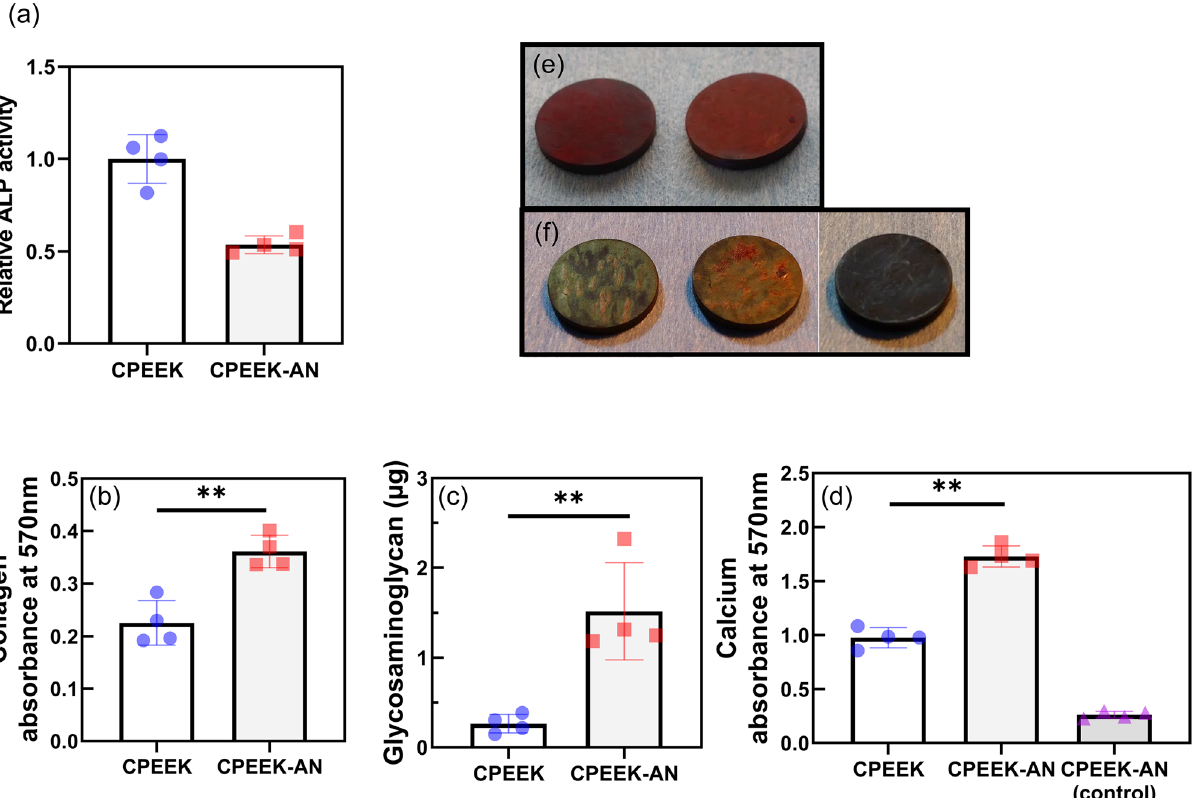
Figure 9. In vitro study2. ( a ) The normalized ALP activity on each substrate. Plots depicting quantifications for ( b ) collagen secretion (absorbance at 570 nm), ( c ) glycosaminoglycan secretion (µg), and ( d ) calcium deposition (570 nm). Gross appearance of ( e ) Sirius red staining for CPEEK (left) and CPEEK-AN (right), and ( f ) alizarin red staining, for CPEEK (left), CPEEK-AN (middle), and control for CPEEK-AN without cells (right). * p < 0.05, ** p <